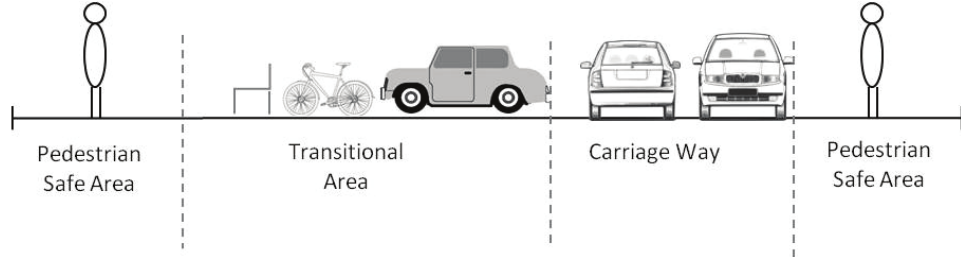
Figure 5. Cross section of Exhibition